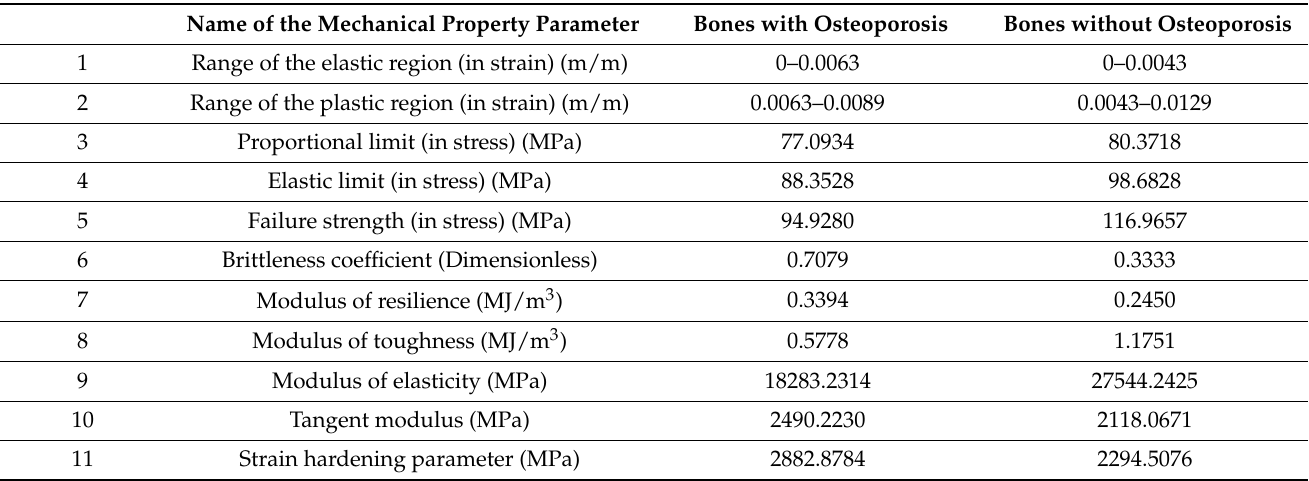
Table 2. Bone mechanical properties using uniaxial tensile stress. Reproduced under the Creative Commons CC-BY license